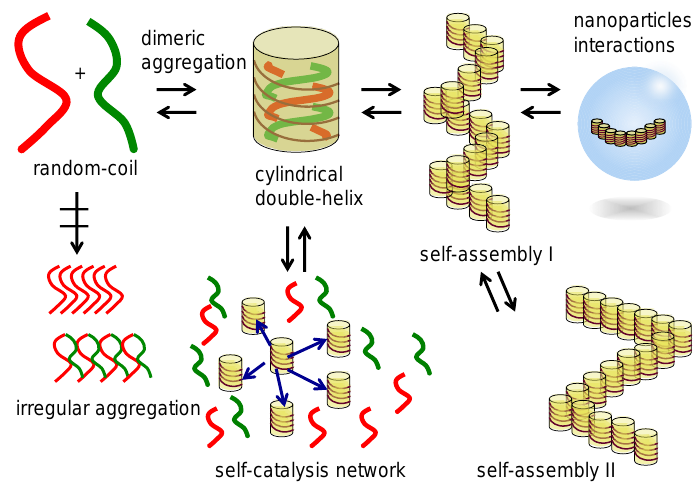
Figure 9. Structure changes of cylindrical molecular complexes of double-helix at the molecular level to self-assembly level in multiple steps manner.